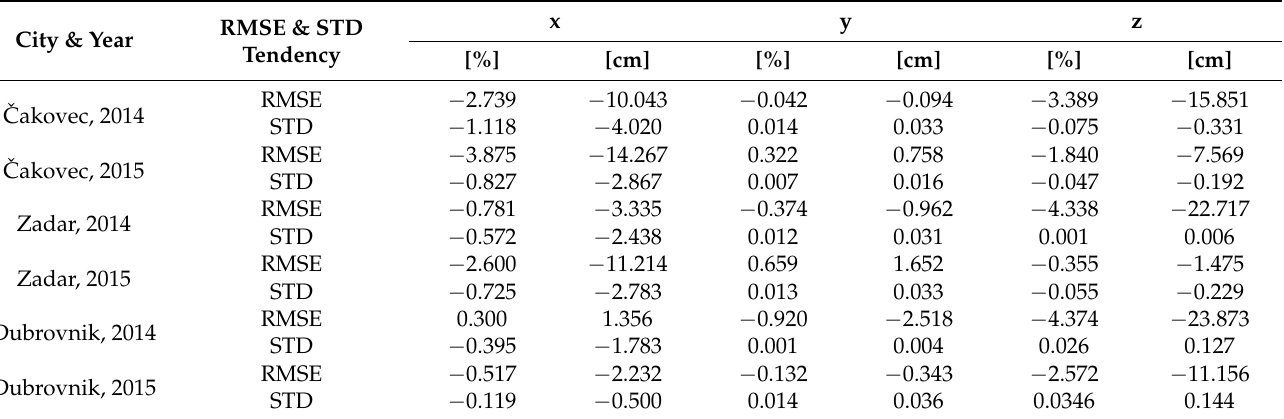
Table 9. Total results of RMSE and STD values achieved using the proposed model.